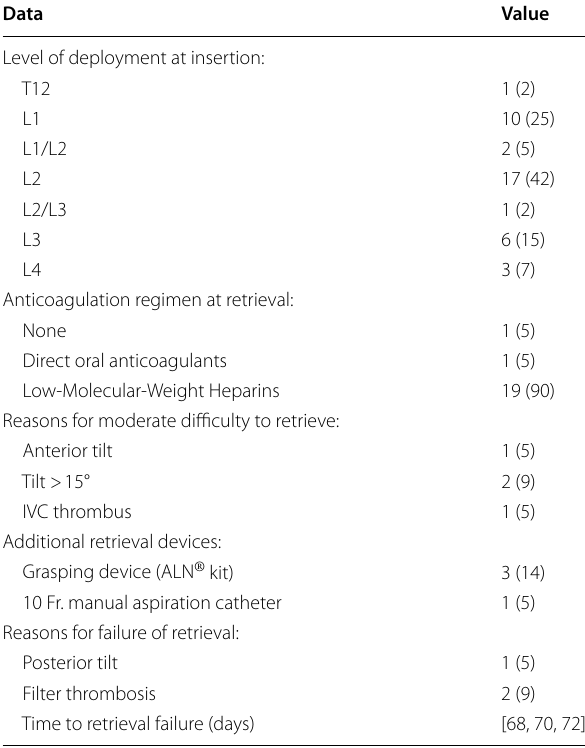
Table 2 Procedural data at implantation and